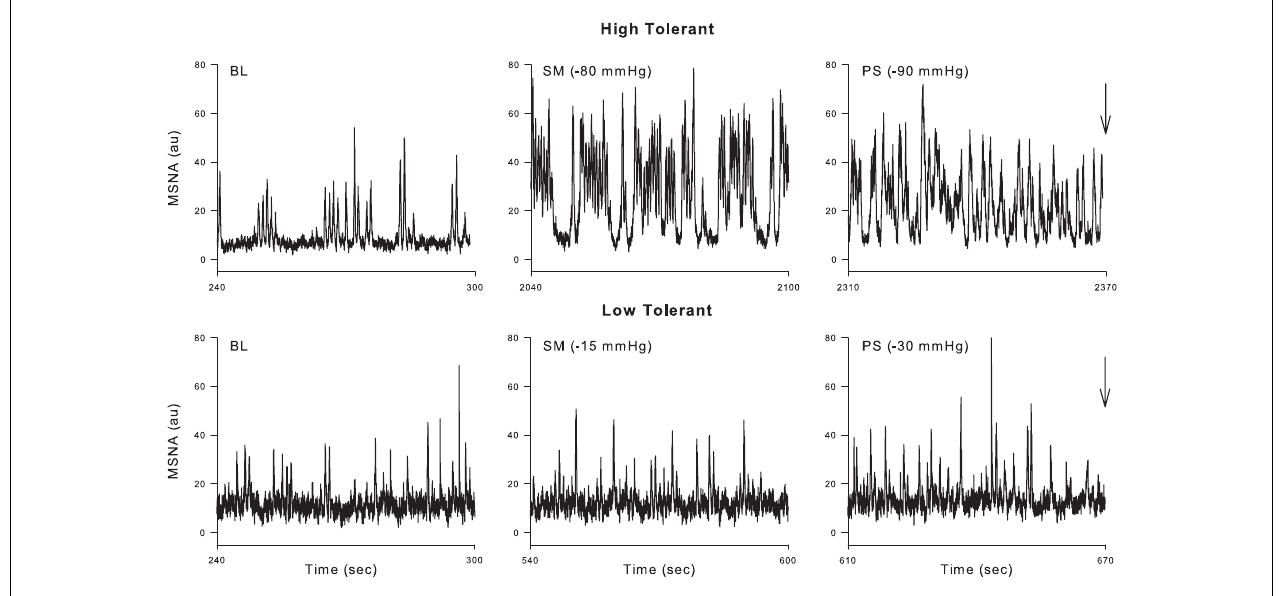
FIGURE 7 | Representative tracings from a high tolerant and low tolerant subject at baseline (BL), sub-maximal LBNP (i.e., the LBNP level before the level at which presyncope was reached; SM) and immediately before presyncope (indicated by arrow;